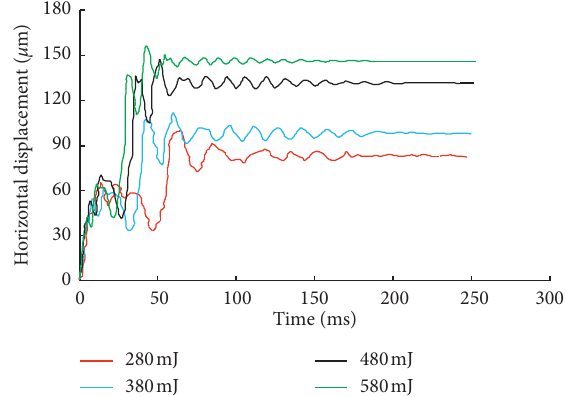
Figure 3: Horizontal displacement-time history curve of the working block under different horizontal static forces [19].